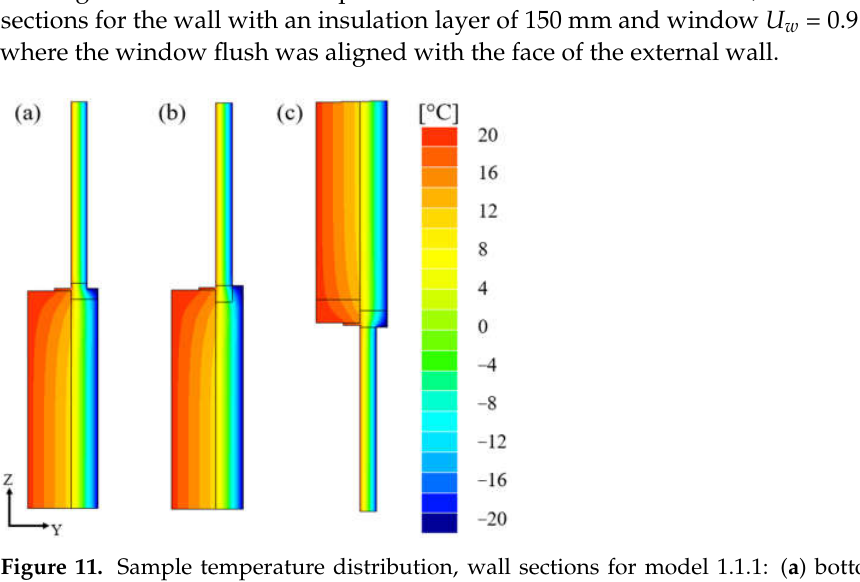
Table 1. Results of efficiency criterion.